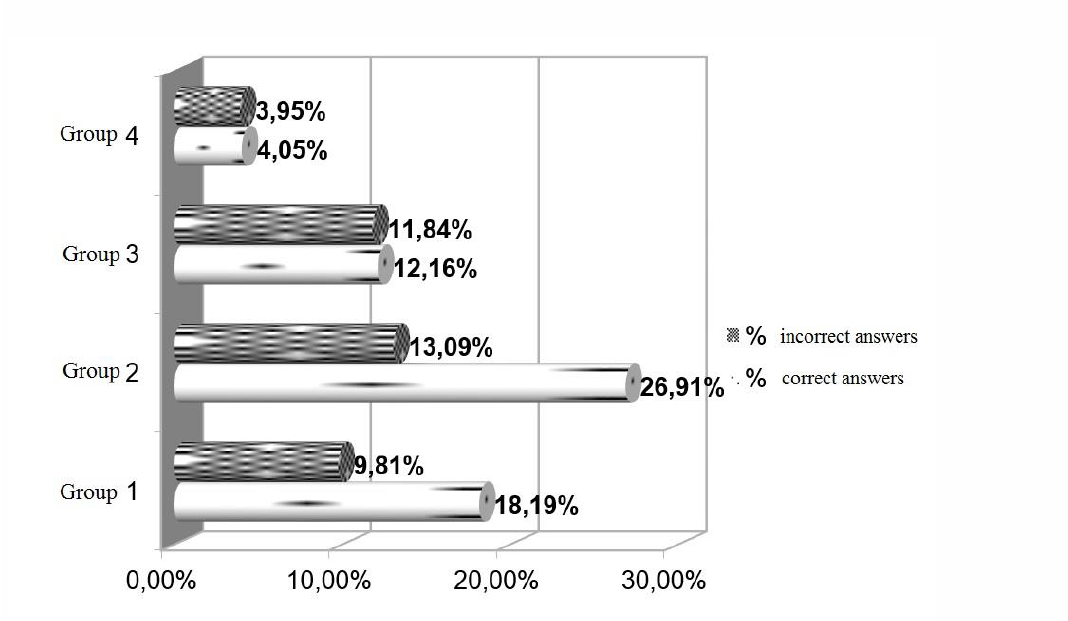
Figure 2. Results of the tasks for each group